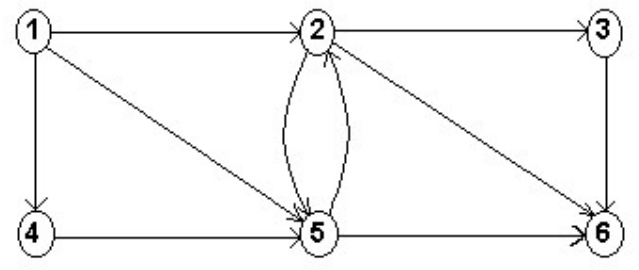
Fig.2 . Example Network 1. (node numbers are written on